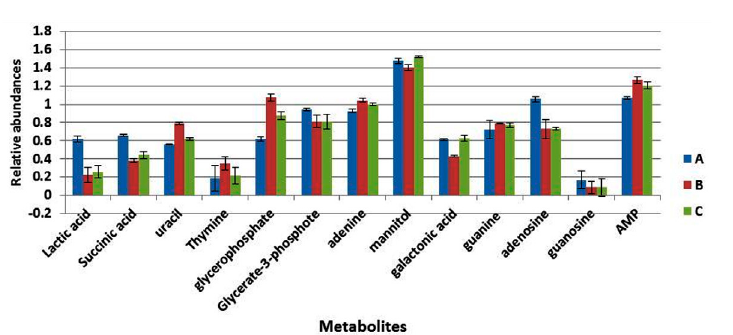
Fig. 5. The relative abundances of cytoplasmic metabolites extracted from clinical isolate of S. aureus harvested at stationary phase from cells grown under normal conditions (A), pH6, 35°C (B) and pH8 at 35°C (C).